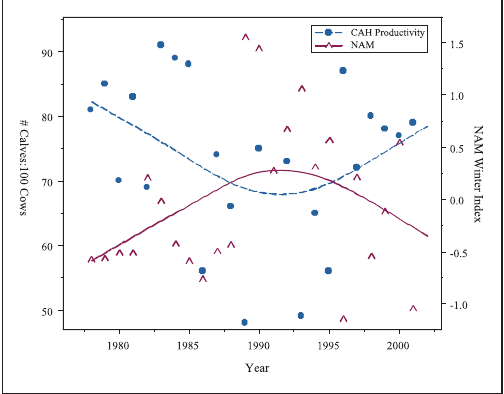
Fig. 1. Spline-smoothed trends of net productivity of the Central Arctic Herd estimated ~1 week after